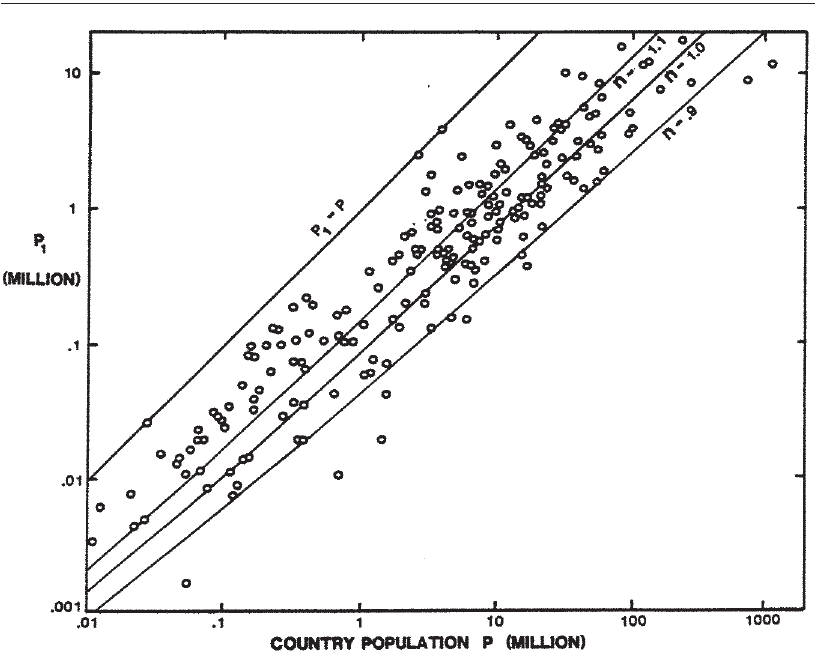
Figure 3 – Population ratio of second-largest and largest cities as a function of the total population of the